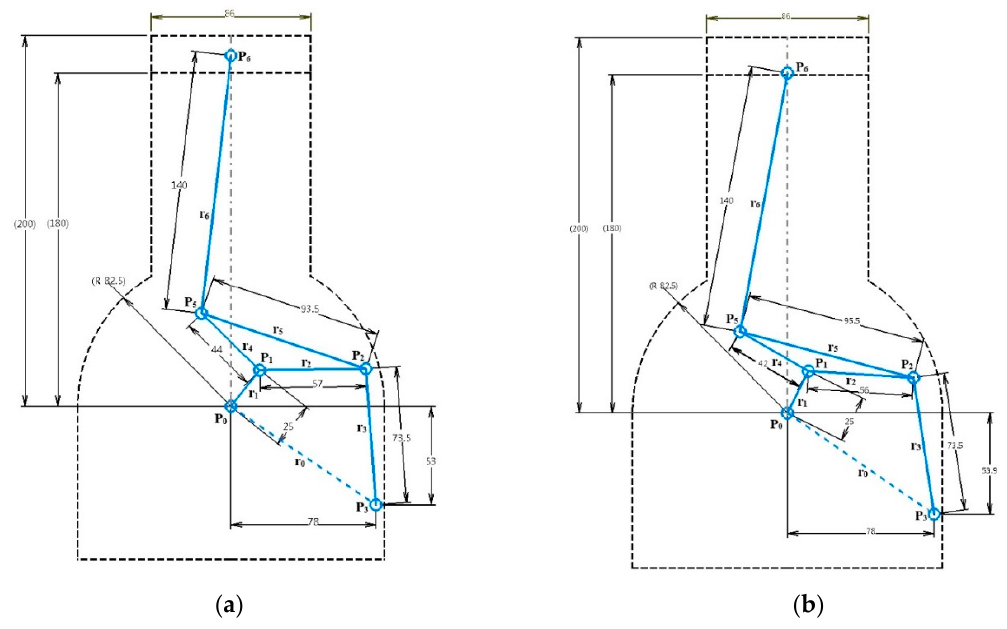
Figure 10. Stephenson III VCR engine mechanism: ( a ) initial design and ( b ) final design.